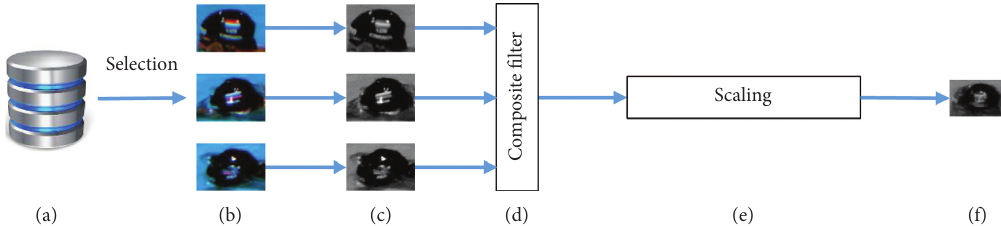
Figure 14: Generation of the Scaled Composite Reference. (a) Database containing head references. (b) Selection of images according to the current situation. (c) RGB color space conversion to grayscale. (d) Application of the composite filter. (e) Rescaling the composite image depending on the size of the concerned lane. (f) Result: Scaled Composite Reference. Swimming Championships in Limoges, France, April 2015.